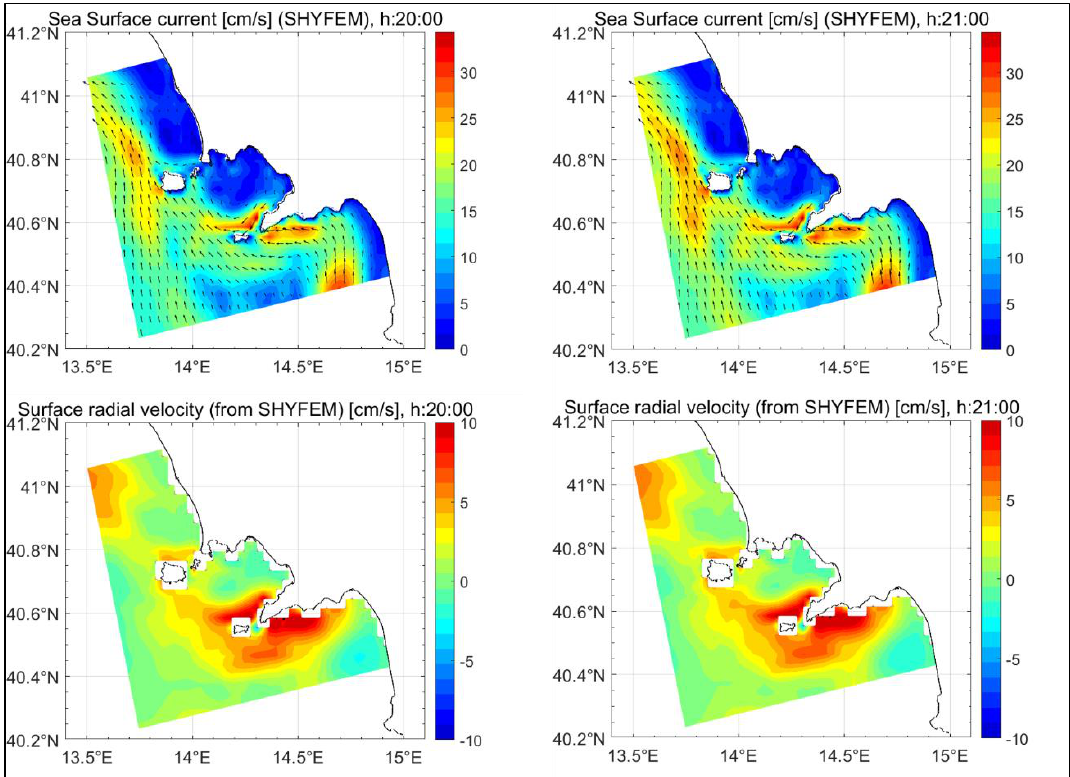
Figure 11. Ocean model results: surface current fields (upper panels) and intensities of the radial components (lower panels), computed for the 0 to 3 m surface water layer depth for the interested domain at the time 22/09/2010, 20:00 and 21:00 UTC.